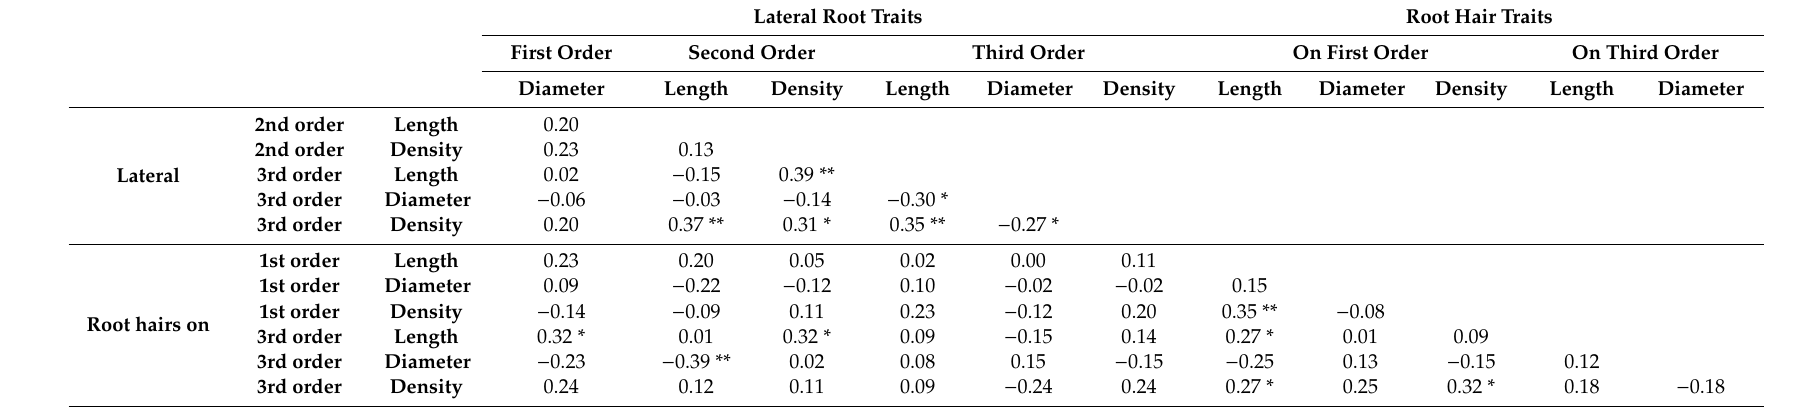
Table 4. Pearson correlation coe ffi cients among root and root hair